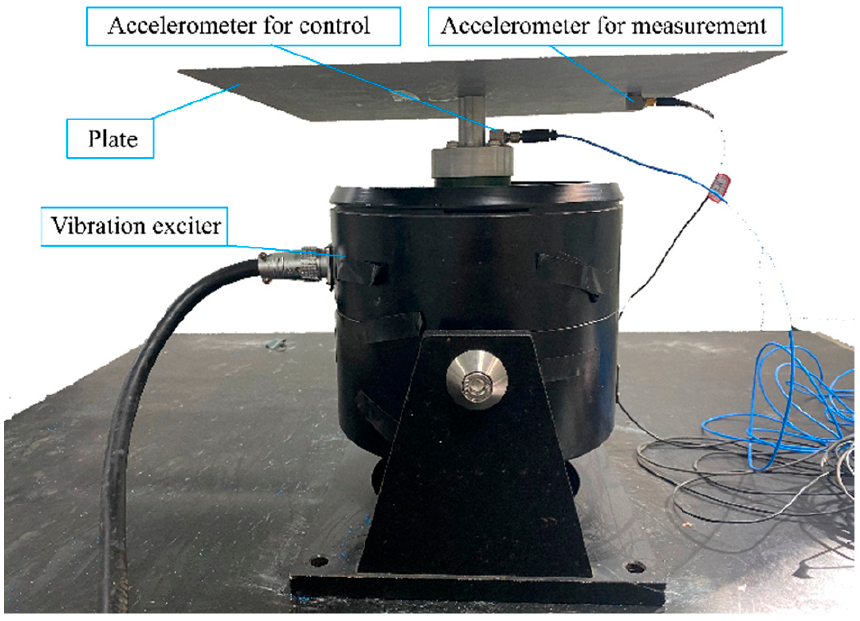
Figure 2. Experimental configuration: The plate and the vibration exciter. To measure the natural frequencies and mode shapes of the plate, a novel measurement system was designed. More specifically, two accelerometers, one for control and the other for measurement, were used to acquire the frequency response data. Compared to the measurement of the natural frequency, it is relatively difficult to measure the mode shape of the structure, since the mode-shape data are different for different locations. To this end, there are some useful techniques based on high-precision laser instruments, which can obtain almost complete mode shapes in a contactless way [22,23]. Nevertheless, most of these techniques are expensive and inoperable. In order to measure full-field mode shapes in a simple and affordable way, a fine-sand vibration method was employed in this study. During test operation, fine colored sand was uniformly spread on the top of the plate (Figure 3), and when the plate resonated, the corresponding mode shape could be observed on the